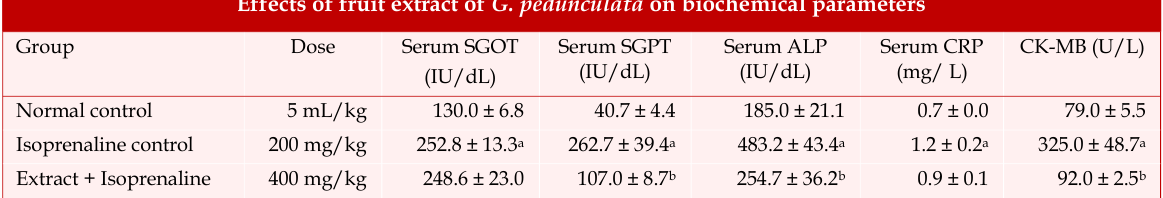
Effects of fruit extract of G. pedunculata on biochemical parameters Group